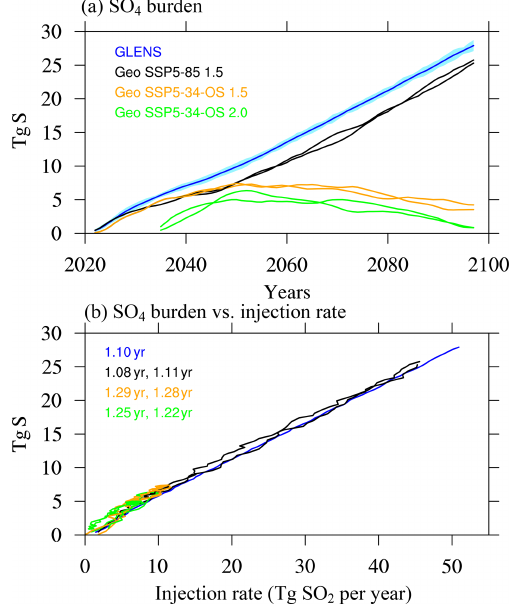
Figure 3. Annual averaged stratospheric sulfate aerosol burden in TgS for the geoengineering injection experiments minus the con- trol with time (a) and injection rate (b) . The stratospheric burden vs. injection amount (in units of years) is listed in the bottom panel for the two ensemble members of each experiment. In addition to the model experiments performed in this study, we add results for GLENS. See text more